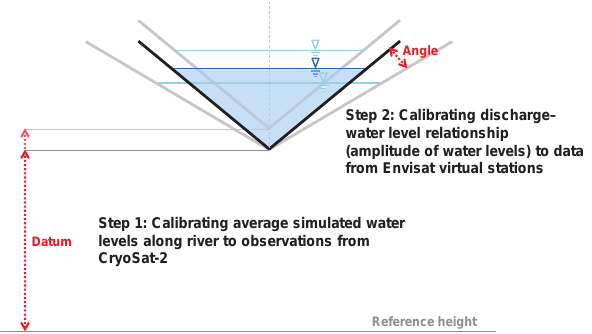
Figure 4. Sketch of the two-step cross-section calibration with their calibration